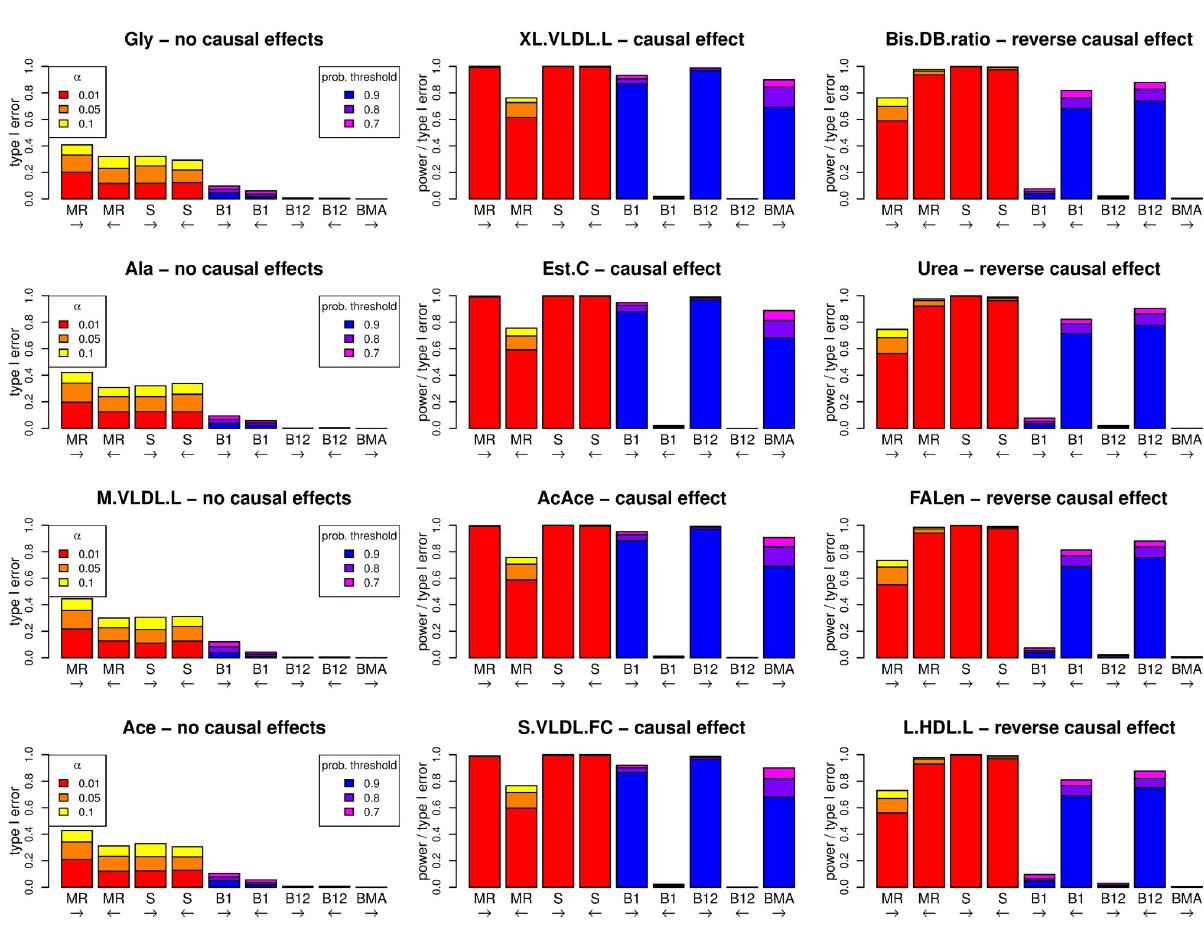
Fig 10. Performance (power and type I error) of different methods under a simulation model with 12 metabolites, an outcome Y, 150 SNPs affecting the metabolites, 75 other SNPs affecting Y, and 9775 SNPs with no effect. Four metabolites (middle panels) have a causal effect on Y, four metabolites (right hand panels) have a reverse causal effect from Y to the metabolite, and four metabolites (left hand panels) have no effects to Y in any direction. The left-to-right arrows show tests for a causal effect from the metabolite to Y, and right-to-left arrows show tests from Y to one of the metabolites. MR: Mendelian randomization using an allele score as an instrumental variable for one of the metabolites or Y. S: SMUT, using SNPs as random effect variables for one of the metabolites or Y. B1: Bayesian network consisting of one metabolite, Y and the two corresponding allele score variables. B12: Bayesian network consisting of all 12 metabolites, Y and all corresponding allele score variables. BMA: multivariable MR based on Bayesian model averaging (MR-BMA).